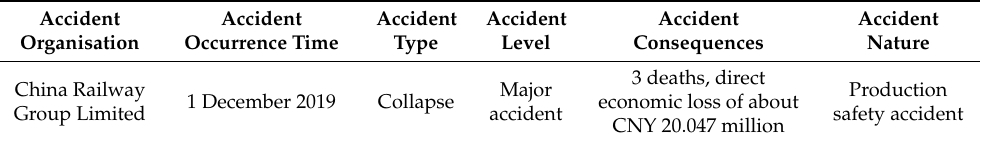
Table 1. Basic information about the accident case.